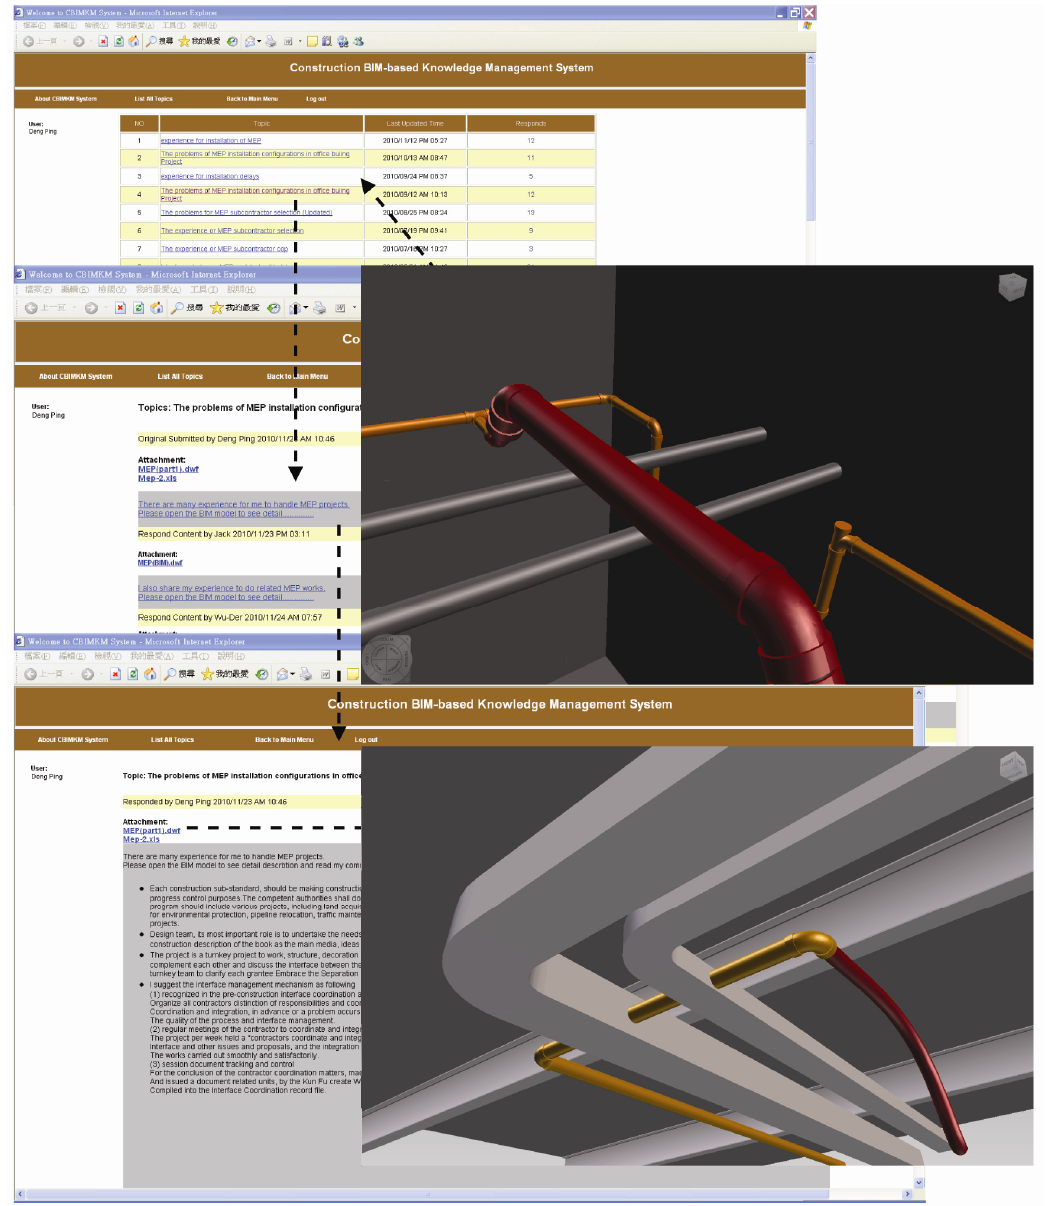
Fig. 5. Visual knowledge and experience sharing in the CBIMKM